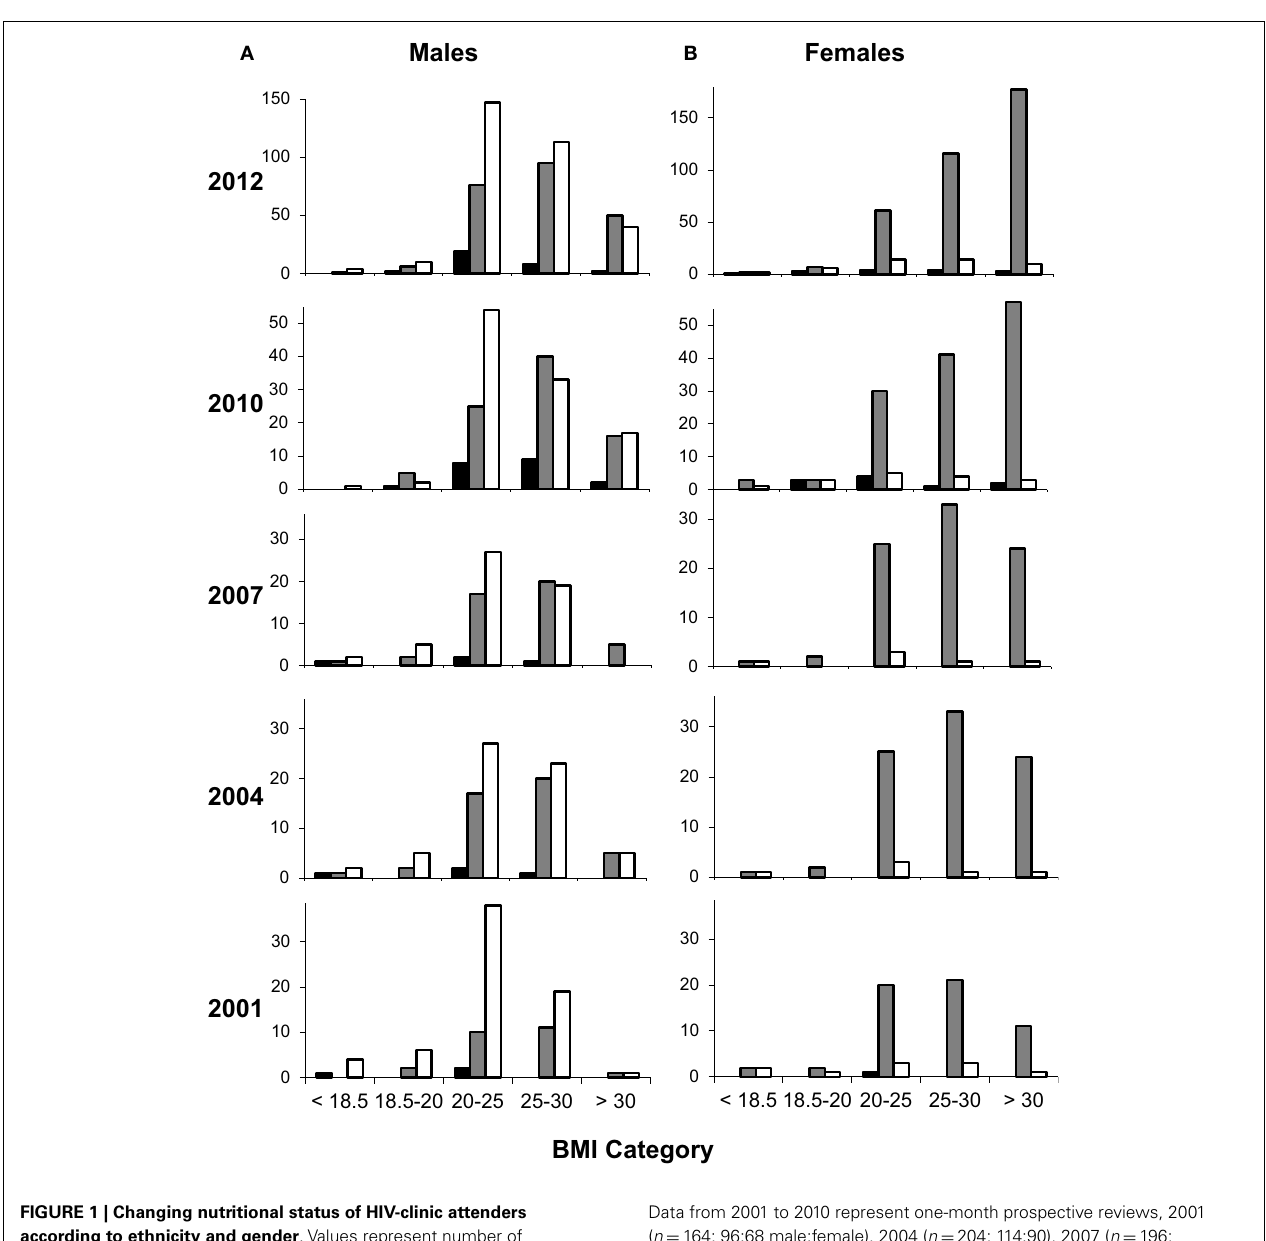
FIGURE 1 | Changing nutritional status of HIV-clinic attenders according to ethnicity and gender .Values represent number of participants by gender [males (A) and females (B) ], ethnicity (filled columns, Asian; shaded columns, black African; open columns, white Caucasian), and by BMI category: wasted ( < 18.5), undernourished (18.5–20), normal (20–25), overweight (25–30), and obese ( > 30kg/m 2 ).